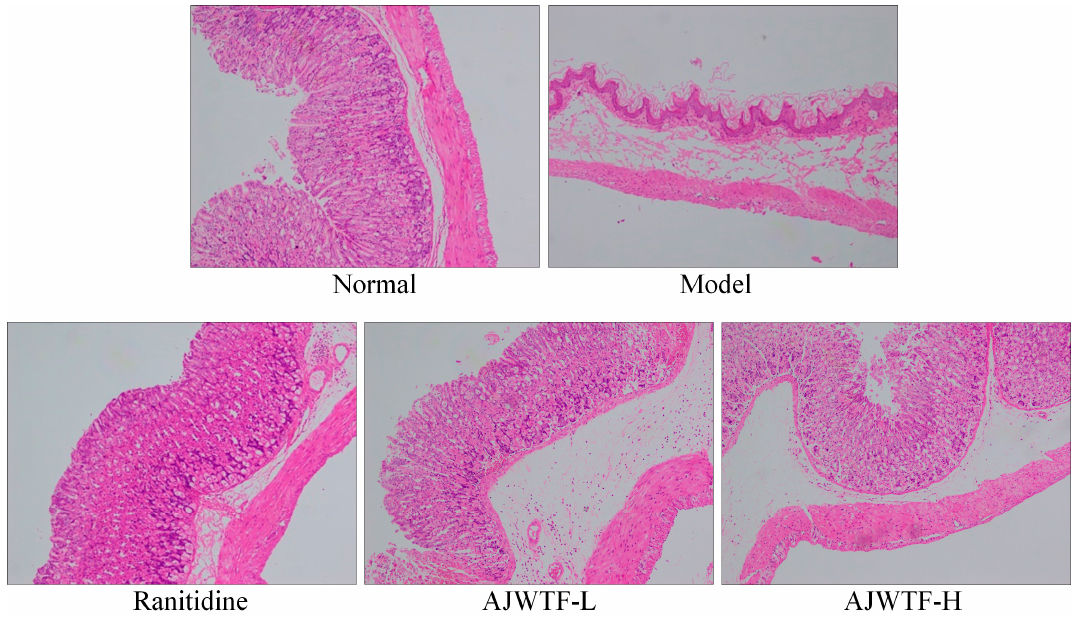
Figure 2. Hematoxylin and eosin-stained stomach sections of mice from each group (100 × ). Ranitidine: Ranitidine at 50 mg/kg body weight (b.w.) by gavage; AJWTF-L: Anji white tea flavonoids at 100 mg/kg b.w. by gavage; AJWTF-H: Anji white tea flavonoids at 200 mg/kg b.w. by gavage.